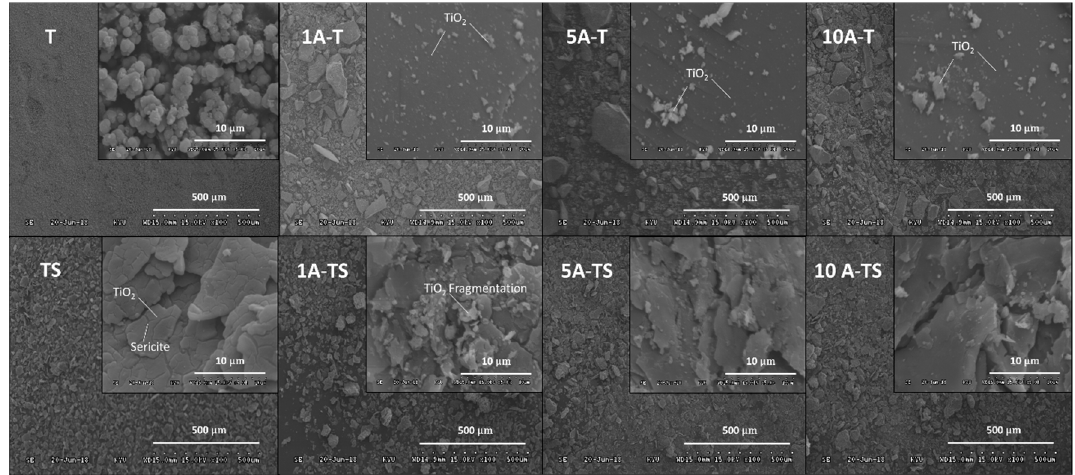
Figure 4. SEM images of the TiO 2 photocatalysts and TiO 2 /sericite photocatalysts.